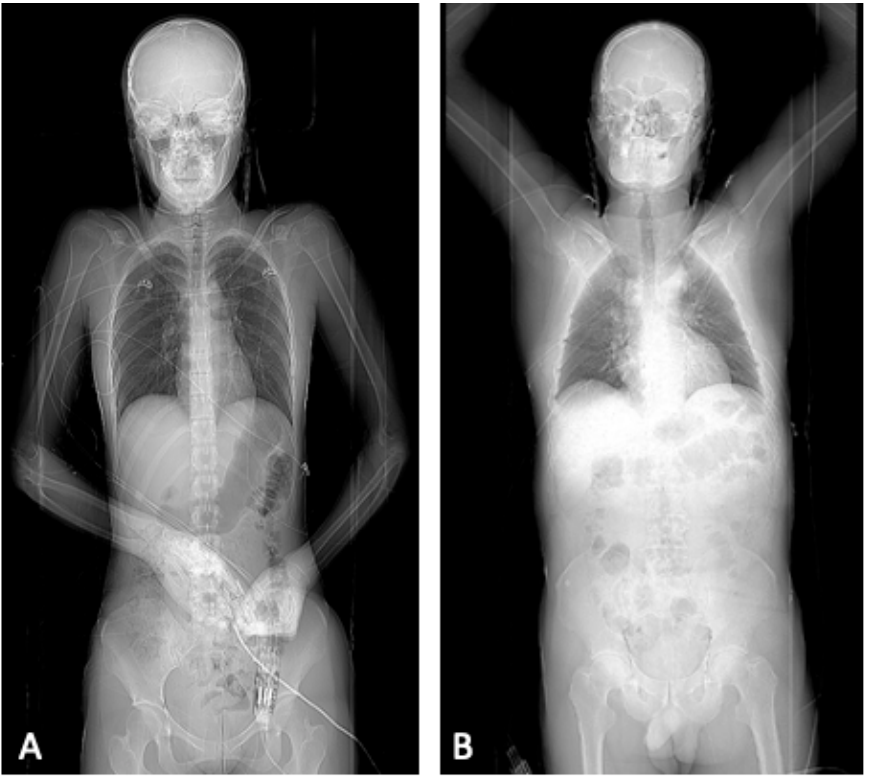
Figure 1. Example for the different positions of the patient during the scout varying between the evaluated computed tomography protocols. Image ( A ) shows the scout obtained for protocol A and B, whereas image ( B ) displays the scout of protocol C.